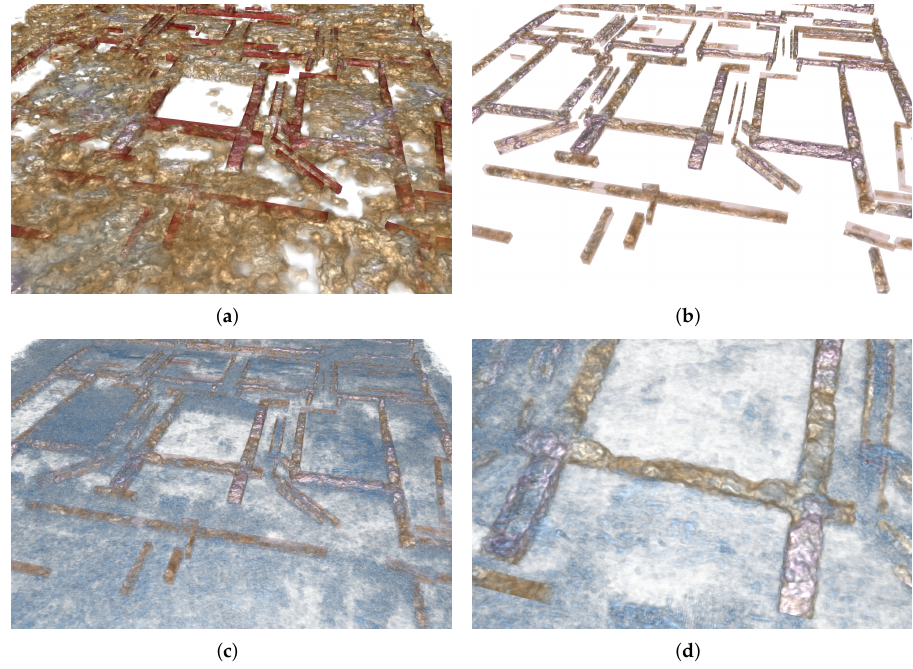
Figure 14. Local visualization control example: Conjoint visualization of filtered GPR dataset and 3D interpretation model ( a ). GPR dataset DVR limited to the inside of the invisible 3D model geometry ( b ). Combination of unfiltered GPR DVR outside and filtered GPR DVR inside the interpretation model. The building floor plan stands out while the remainder of the dataset is still visible. Wall surface details are visible despite the simplistic nature of the interpretation ( c , d